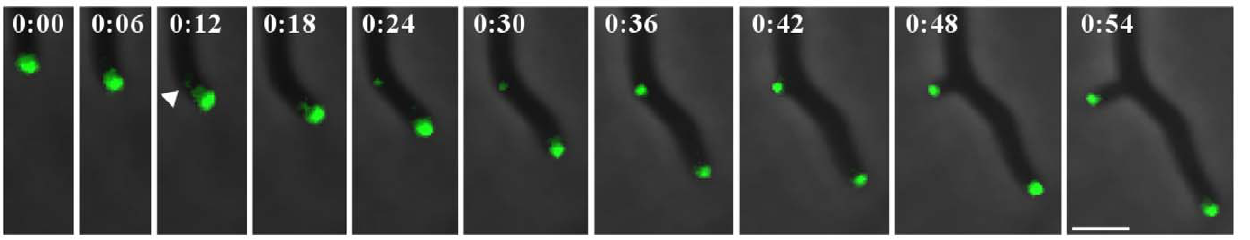
Figure 1. Evidence of tip-focus splitting, growth of foci and emergence of branches, in fluorescence-imaged Streptomycescoelicolor expressing divIVA-egfp . The tip always contains a large DivIVA focus and established tips extend at an approximately constant speed. At about 12 minutes, the DivIVA tip-focus undergoes splitting, leaving behind a new focus (arrow). As the tip continues to extend, the new focus remains in place on the membrane and grows in intensity. After about 42 minutes a new branch is formed at the position of the new focus, with the new focus now sitting at the tip of the new branch. Both the new branch and the original branch now continue to extend in length. Time in hours:minutes. Scale bar: 3 m m .